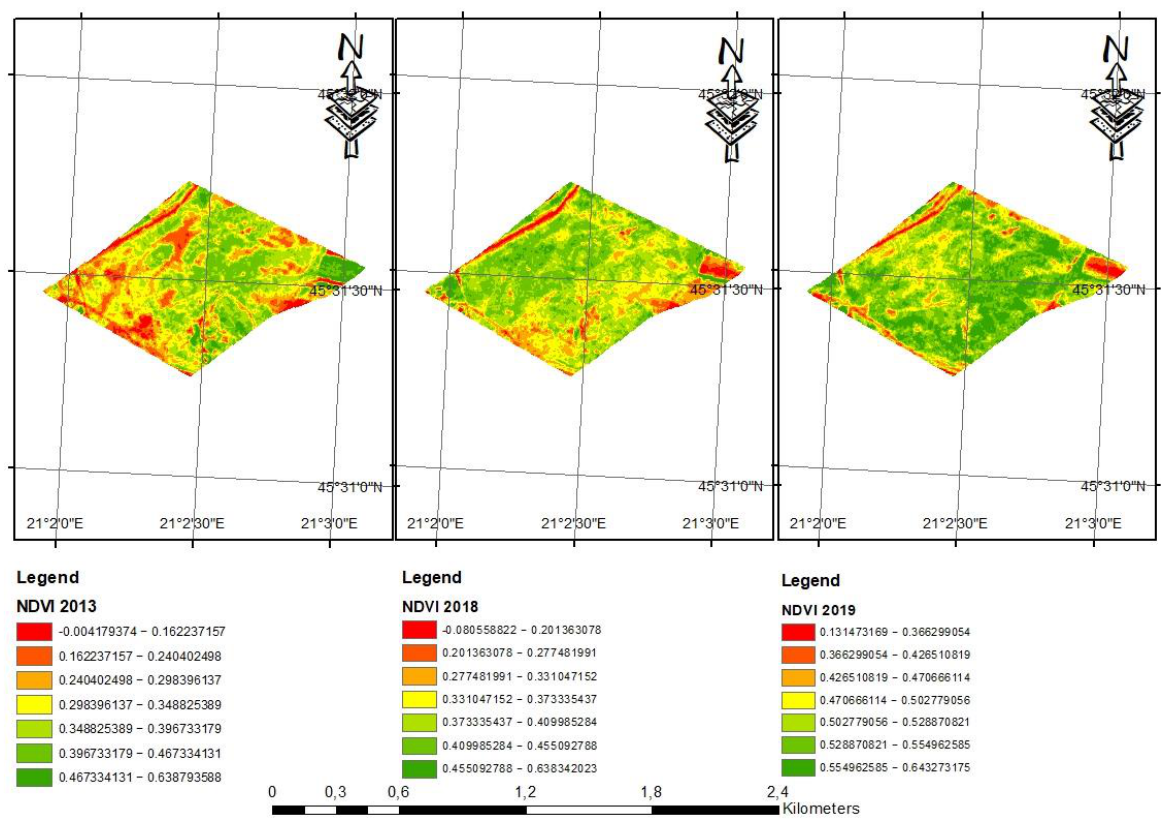
Figure 5. NDVI map for plot P808, pasture category, under the influence of pig sludge. Table 8. Variation of land area of the pasture category, by NDVI classes, under the influence of pig sludge application, plot P816.